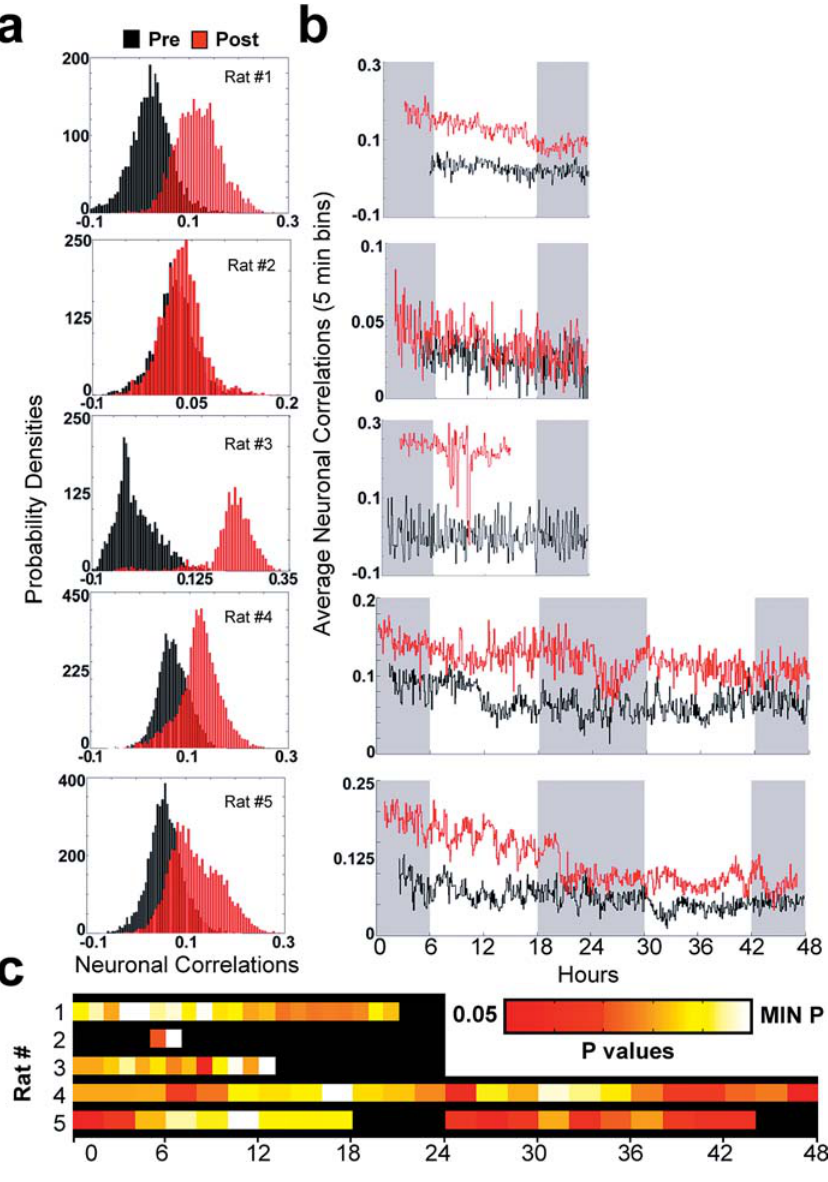
Figure 2. Neuronal Ensemble Correlations Including up to Four Forebrain Regions Reveal Long-Lasting Reverberation (A) Postnovelty neuronal correlations were significantly larger than prenovelty correlations in all animals studied. (B) Temporal profiles of neuronal en- semble correlations. Gray bands indicate lights-off; white bands indicate lights-on. (C) Temporal evolution of p values associated with pre- and postnovelty Bonferroni comparisons performed in intervals of 1 h (rats 1–3) or 2 h (rats 4 and 5). Significant experience-depend- ent neuronal reverberation was detected up to 48 h after novel stimulation. Color bar in linear scale; black denotes p . 0.05. The minimum p values (MIN P) were, respectively, 10 (cid:1) 14 , 10 (cid:1) 3 , 10 (cid:1) 12